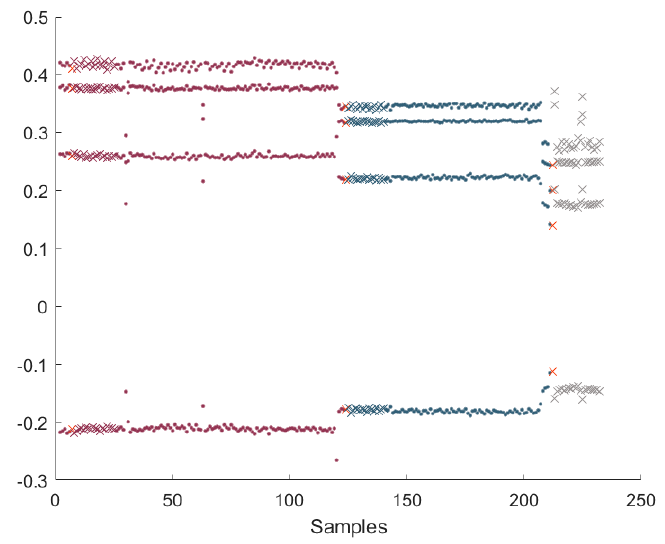
Figure 10. Results of the AAD + ADP algorithm (suction cups). Table 6. Performances of the clustering-based from scratch approach (suction cups).